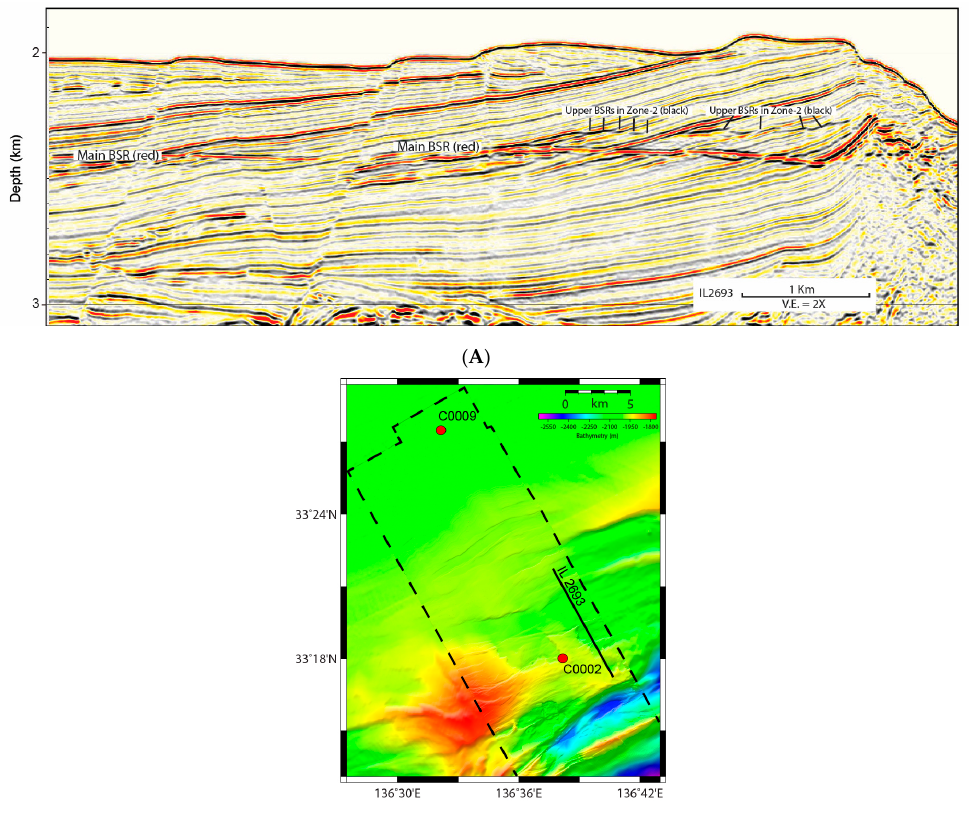
Figure 7. ( A ) Inline 2693 showing representative cross section of the Upper BSRs in Zone-2. These BSRs appear as strong, patchy, positive polarity crosscutting reflections. ( B ) Bathymetric map of the study zone with the extent of IL 2693 shown for reference.